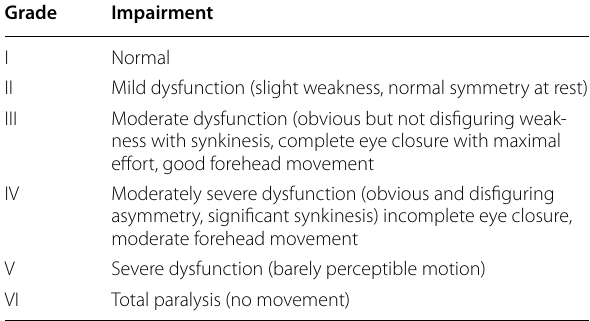
Table 1 House–Brackmann facial paralysis scale